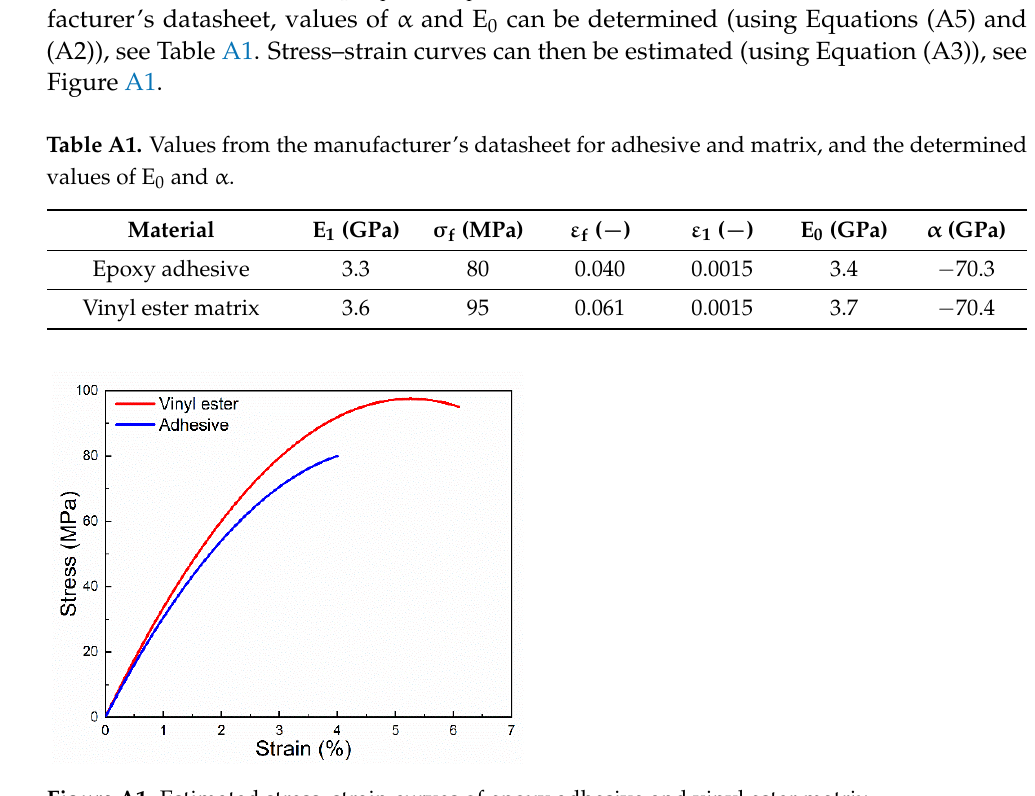
Figure A1. Estimated stress–strain curves of epoxy adhesive and vinyl ester matrix.